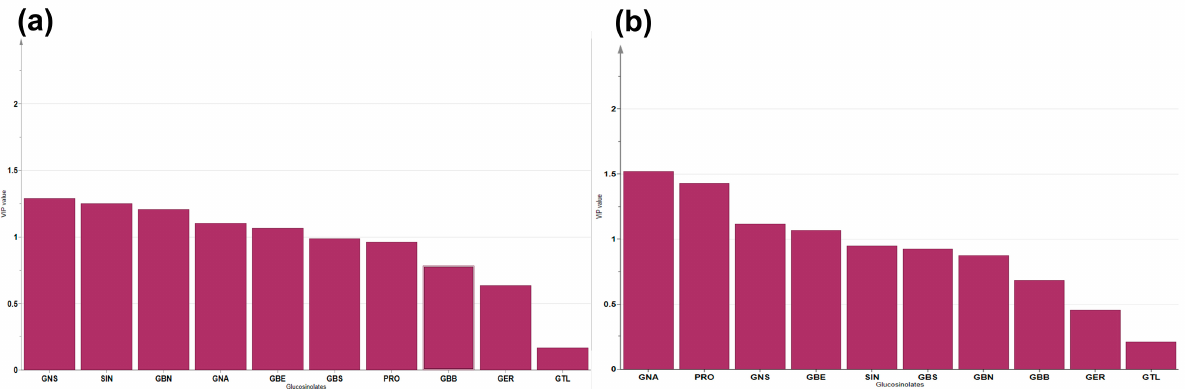
Figure 5. 3D Orthogonal projections to latent structure discriminant analysis (OPLS-DA) score plots of Chinese cabbage germplasms. The score plot was clustered based on status (cultivar or landrace) and origin (Korea, China, Taiwan, and Japan). Clustered into two statuses ( a ); and four origins ( b ); respectively.